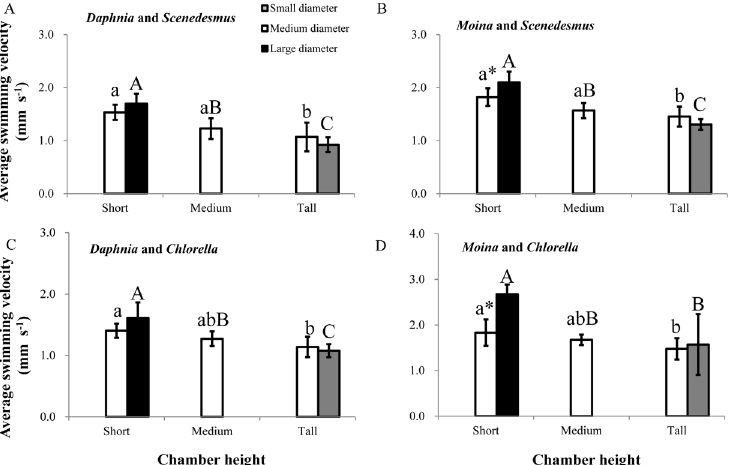
Fig 2. Average swimming velocity (means ± s. d, n = 6) of grazer species in different plankton systems under three levels of chamber height and three levels of base diameter. (A) Daphnia magna fed with Scenedesmus quadricauda , (B) Moina micrura fed with S . quadricauda , (C) D . magna fed with Chlorella vulgaris , (D) M . micrura fed with C . vulgaris . Different lowercase letters indicate significant chamber height effect among treatments at a given base diameter. Different upper case letters indicate significant chamber shape effect at a given chamber volume. “ * ” indicates a significant difference between two treatments at a given chamber height.